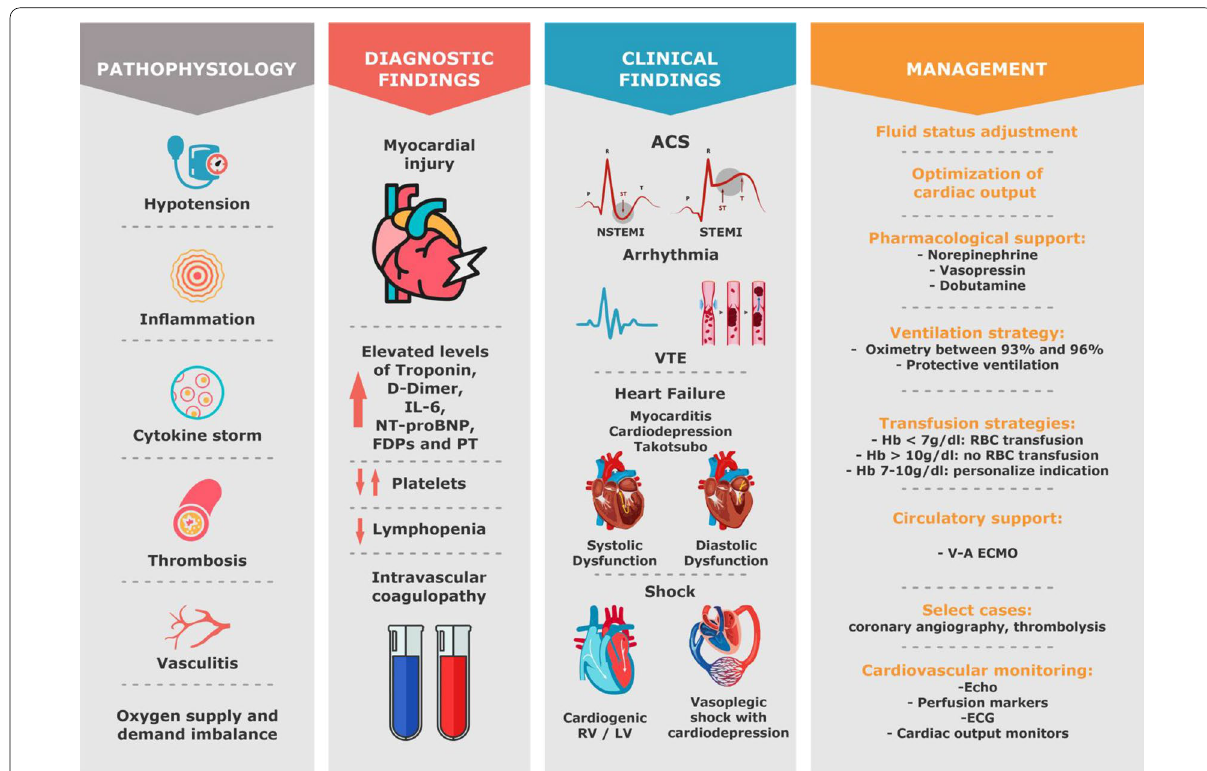
Fig. 3 Cardiovascular involvement in patients with COVID‑19; pathophysiology, diagnostic findings, most common clinical findings and proposed management. IL-6 interleukine‑6, FDPs fibrin degradation product, PT prothrombin time, ACS acute coronary syndrome, NSTEMI non‑ST elevation myocardial infarction, STEMI ST elevation myocardial infarction, VTE venous thromboembolism, RV right ventricle, LV left ventricle, Hb hemoglobin, V-A venous‑arterial, Echo echocardiography, ECG